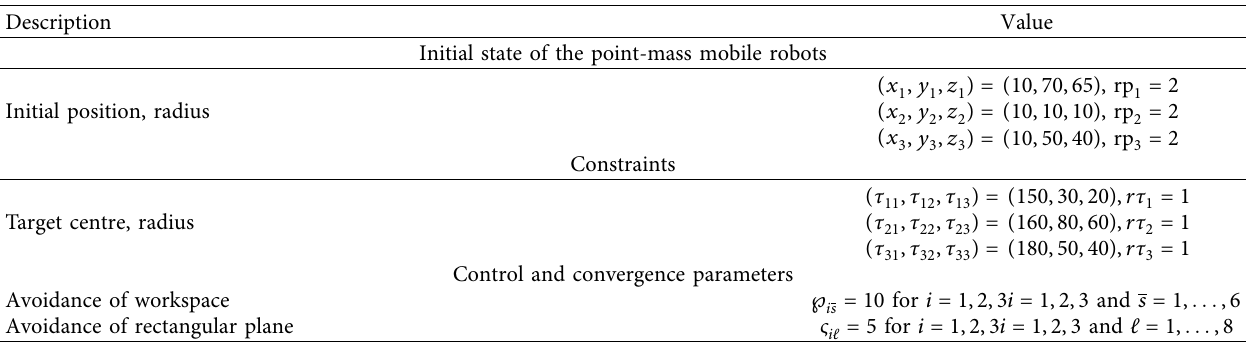
Table 3: Scenario 3. The parameters utilised in the numerical simulation, with n � 3 and m � 8.